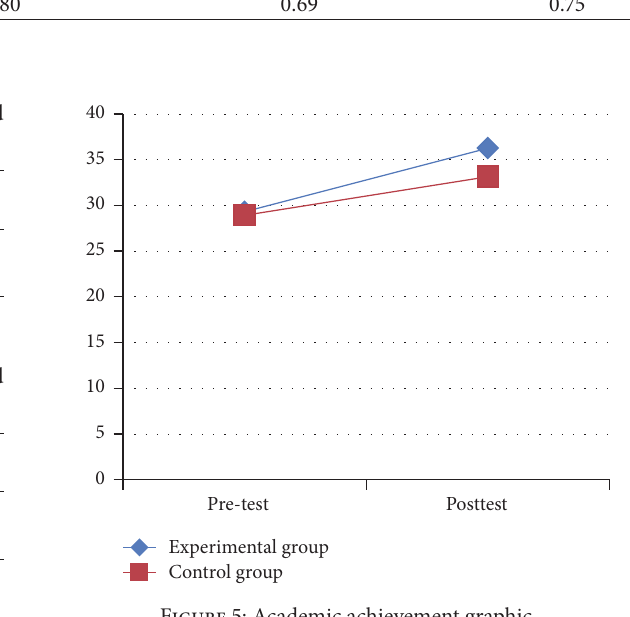
Table 5: Independent groups 𝑡 -test results related to the pretest scores of the experimental and control group.